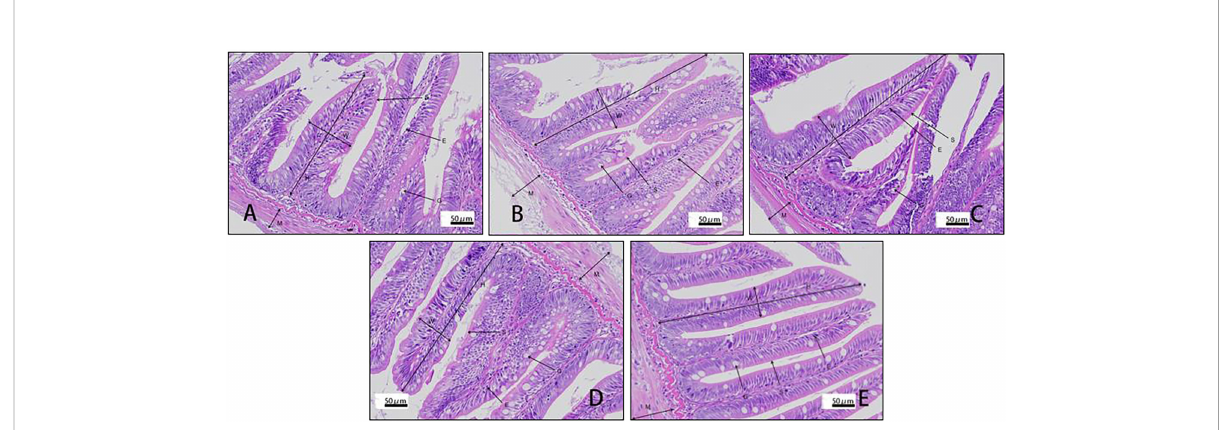
FIGURE 3 Histology of proximal intestine in rainbow trout fed graded cottonseed protein concentrate. (A) FM; (B) CPC25%; (C) CPC50%; (D) CPC75%; (E) CPC100%. W-villus width, H-villus height, M-muscular layer thickness, S-striatum; G-goblet cells and E-epithelial